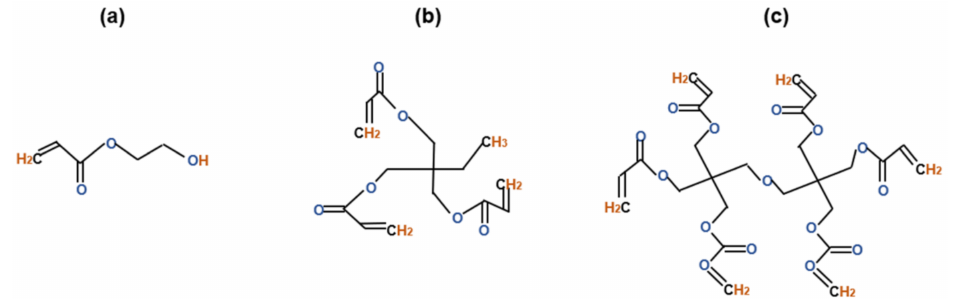
Figure 1. UV-curable polymers used in this research and their structures of chemical molecules: ( a ) 2-hydroxyethyl acrylate, ( b ) tripropylene glycol diacrylate, and ( c ) dipentaerythritol hexaacrylate.